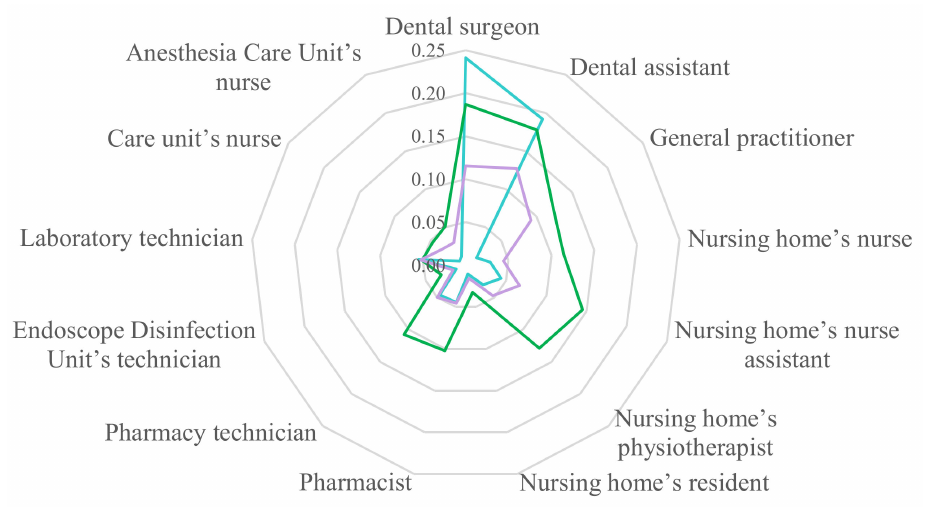
Figure 1. Hazard quotients of ethylbenzene (blue), 2-ethyl-1-hexanol (green) and acetone (purple). Limonene and isovaleraldehyde are among the molecules for which the HQs could not be calculated due to the lack of an available